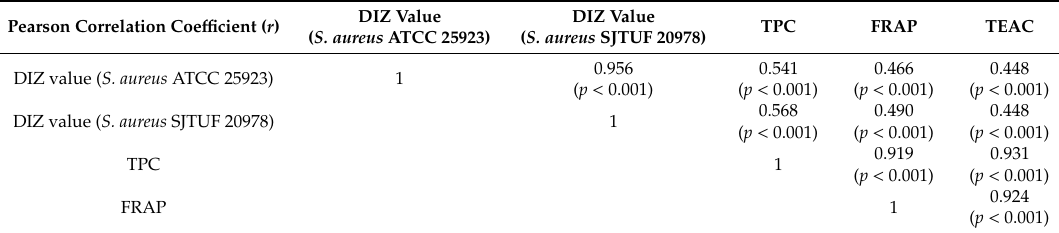
Table5. Correlationanalysisamongantibacterialactivity, antioxidantactivity, andtotalphenoliccontent. DIZ Value DIZ Value Pearson Correlation Coe ffi cient ( r ) ( S. aureus ATCC 25923) ( S. aureus SJTUF 20978) DIZ value ( S. aureus ATCC